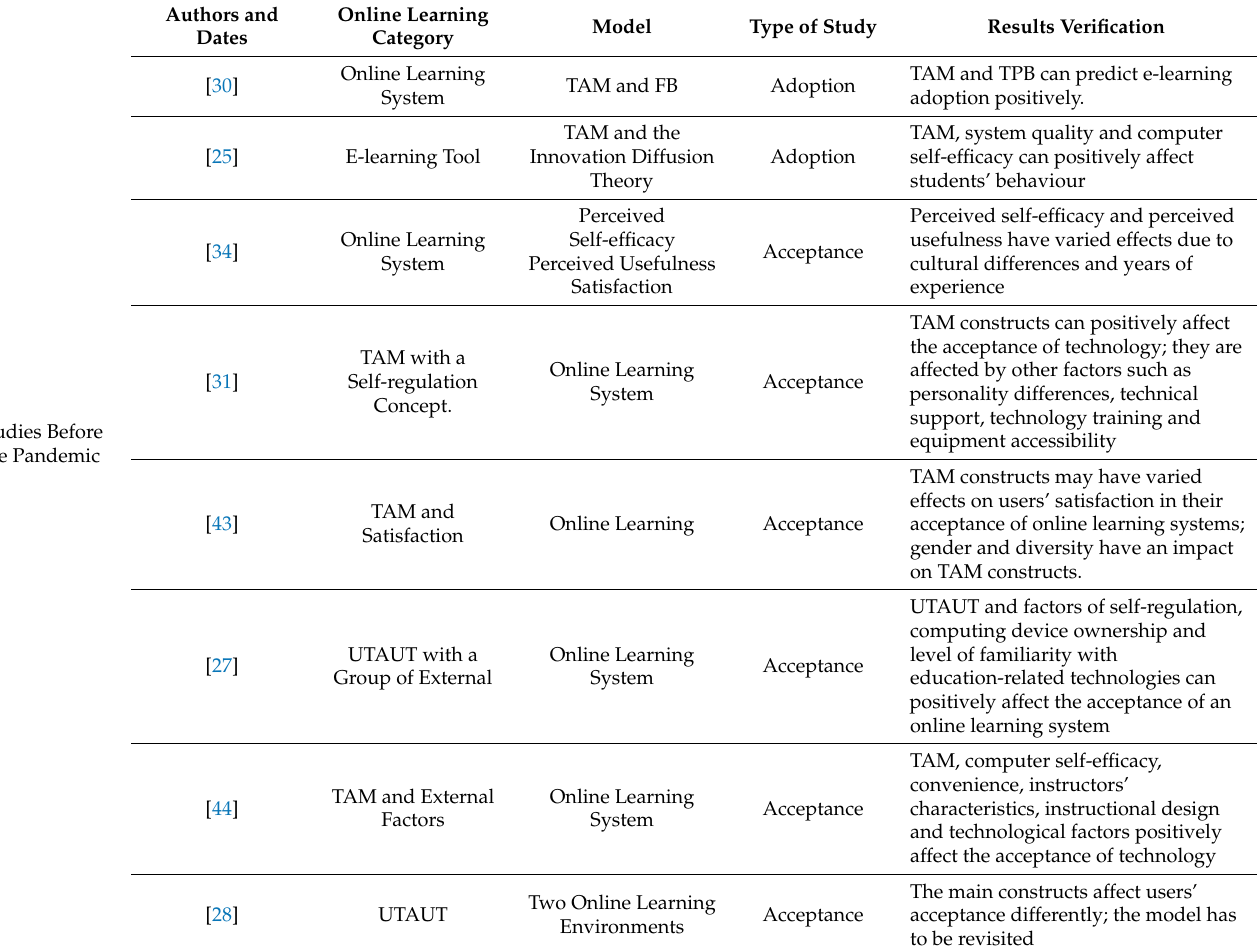
Table 1. Studies before and after the outbreak of the